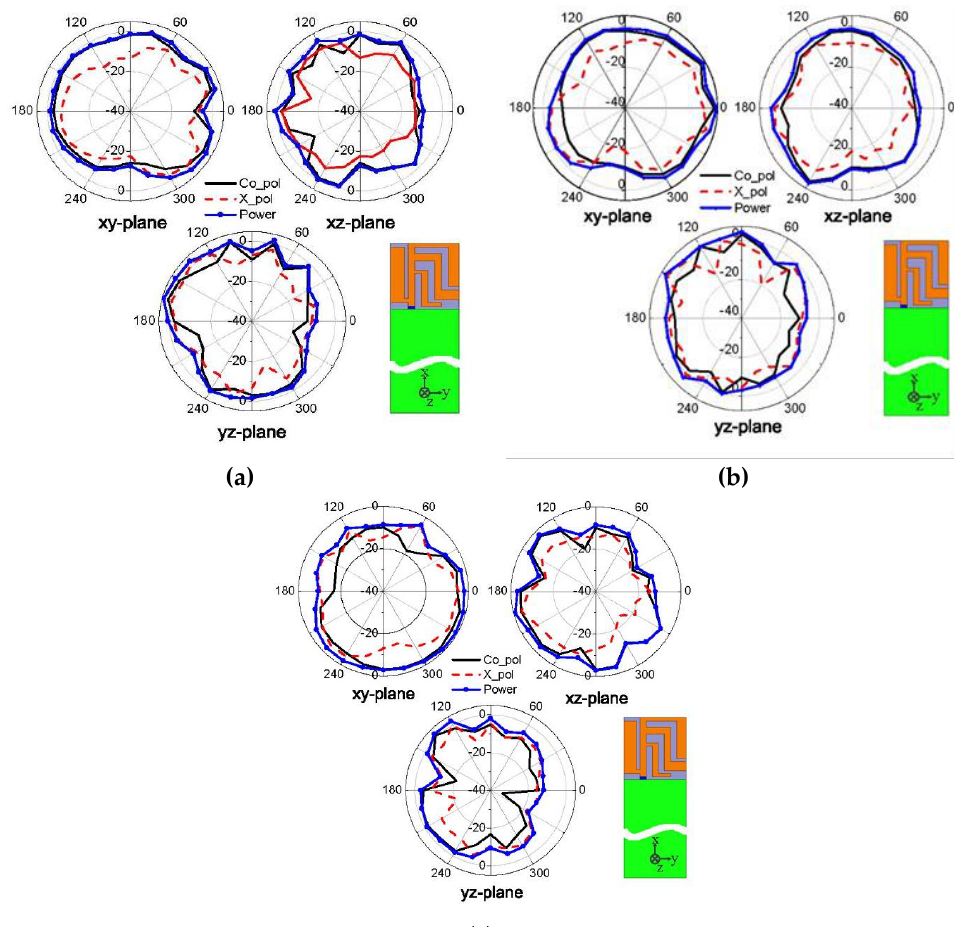
Figure 15. Two-dimensional normalized radiation pattern of the planar USB dongle antenna at ( a ) 2.45 GHz, ( b ) 3.51 GHz, and ( c ) 5.45 GHz.